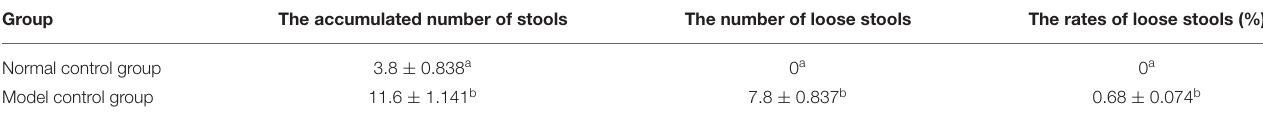
TABLE 2 | Establishment of a mouse model of stress diarrhea. Group